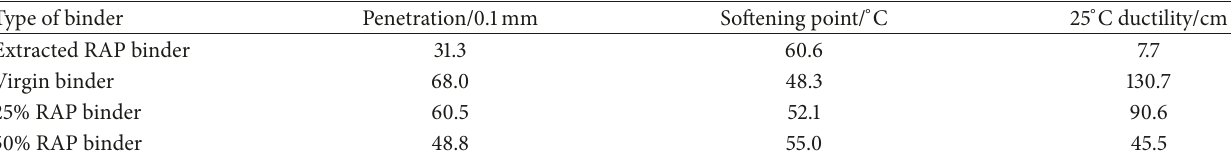
Table 2: Basic properties of binders with different RAP contents.